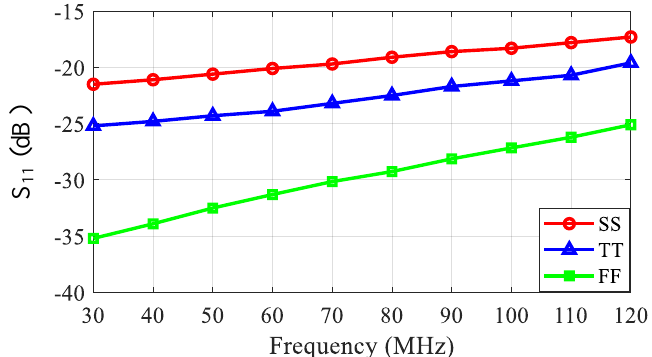
Figure 11. Simulated S 11 of the proposed LNA, where SS, TT, and FF stand for the slow PMOS and NMOS, typical PMOS and NMOS, and fast PMOS and NMOS process corners, respectively.